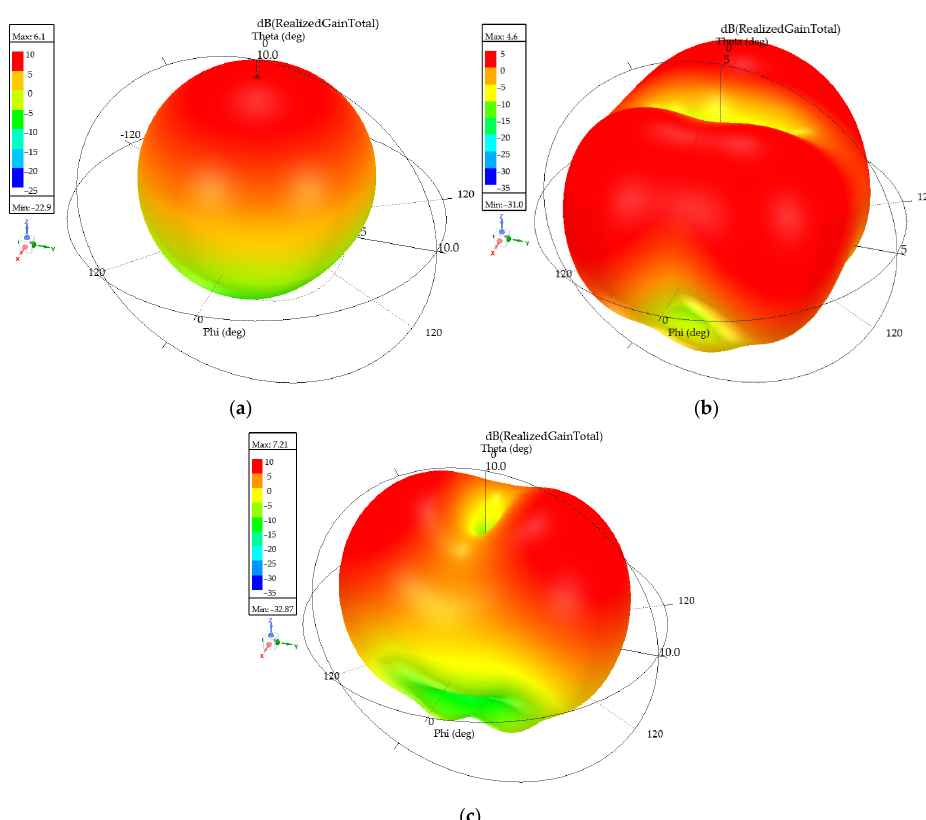
Figure 4. Three ‐ dimensional realized gain diagrams of MPATSAT: ( a ) for 2.45 GHz; ( b ) for 4.73 GHz; ( c ) for 5.21 GHz. |Z11| parameter plot of MPATSAT is given in Figure 5. Input impedances were tuned to ~50 Ω for resonance frequencies. Input impedances are 47.45 Ω , 44.80 Ω , and 47.02 for 2.45 GHz, 4.73 GHz, and 5.21 GHz, respectively.